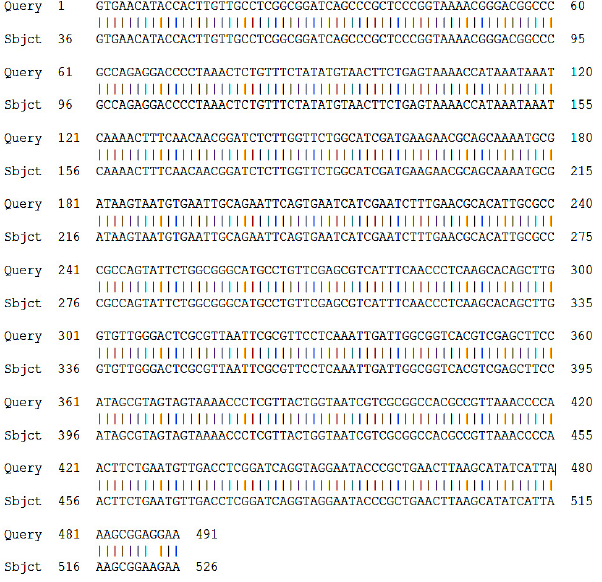
Fig. 3. Sequence analysis (491 bases) with (NCBI sequence